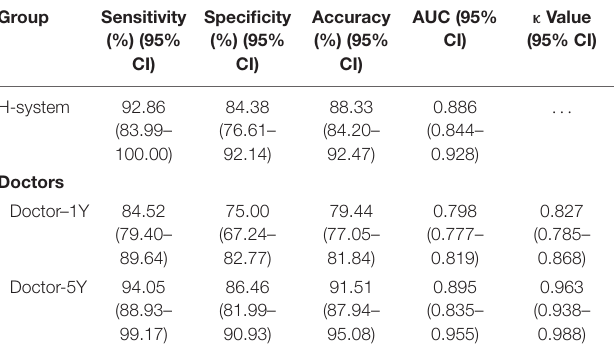
TABLE 4 | Comparison of efficiency for handling 60 cases among H-system and doctors.